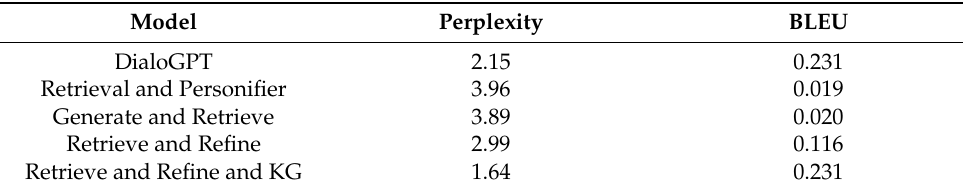
Table 4. Comparison of the performance metrics for the tested models.